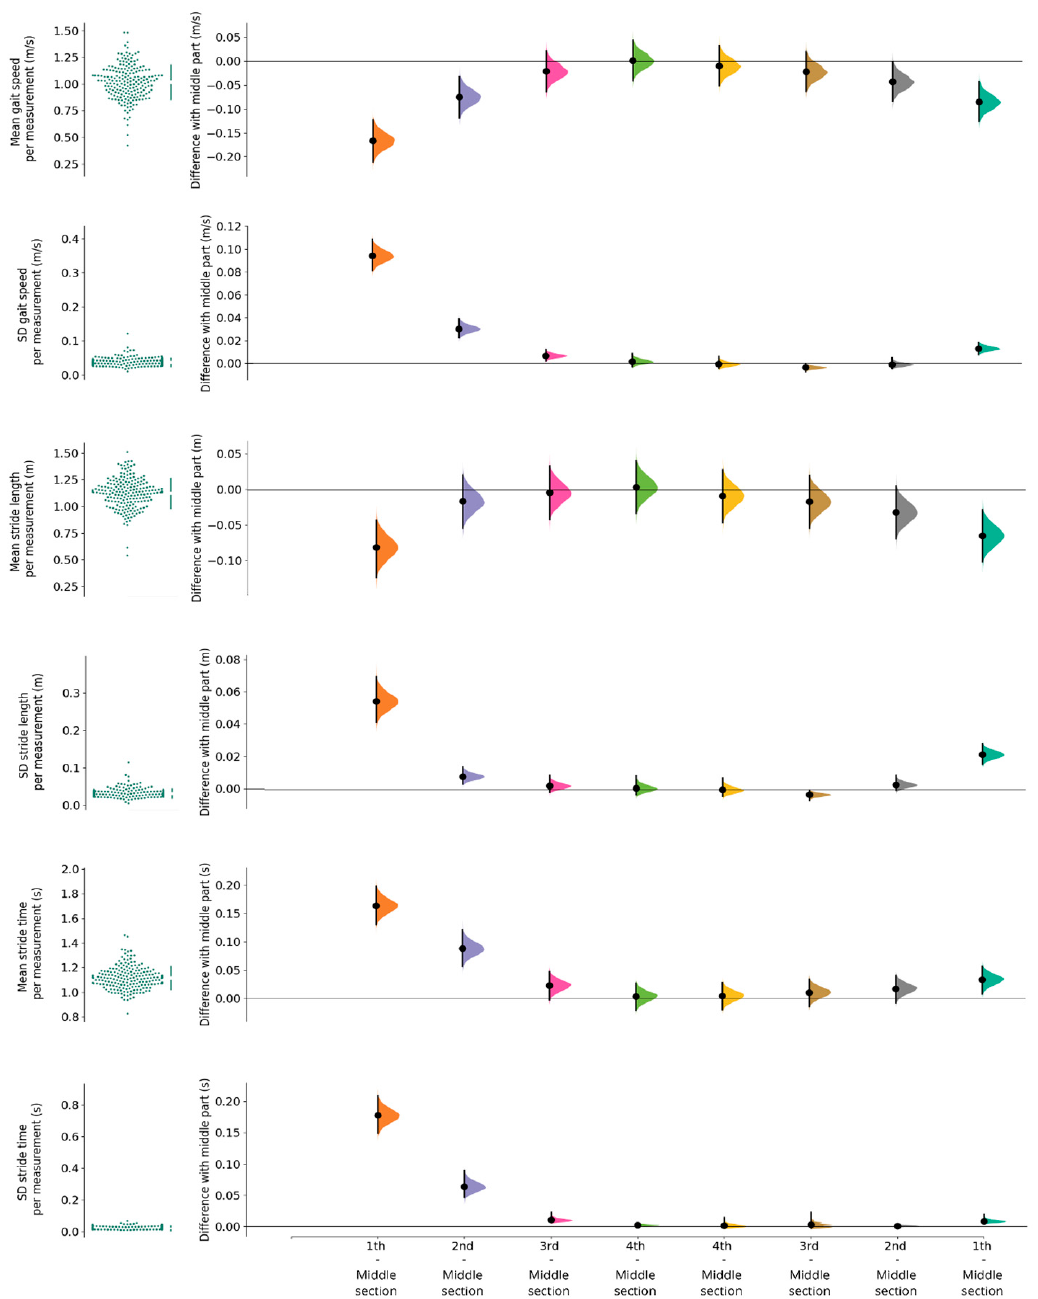
Figure 5. Subplots of the means and SDs of the strides in the middle section of the walking trajectory, and the mean differences and associated 99% CI of the first 4 strides around a turn. The first 4 strides after a turn show increasing speed and stride length with decreasing stride time. The last 4 strides before a turn show decreasing speed and stride length with increasing stride time. The difference between these strides with the mean gait speed, stride length and stride time of the middle section of the walkway are plotted in the lower